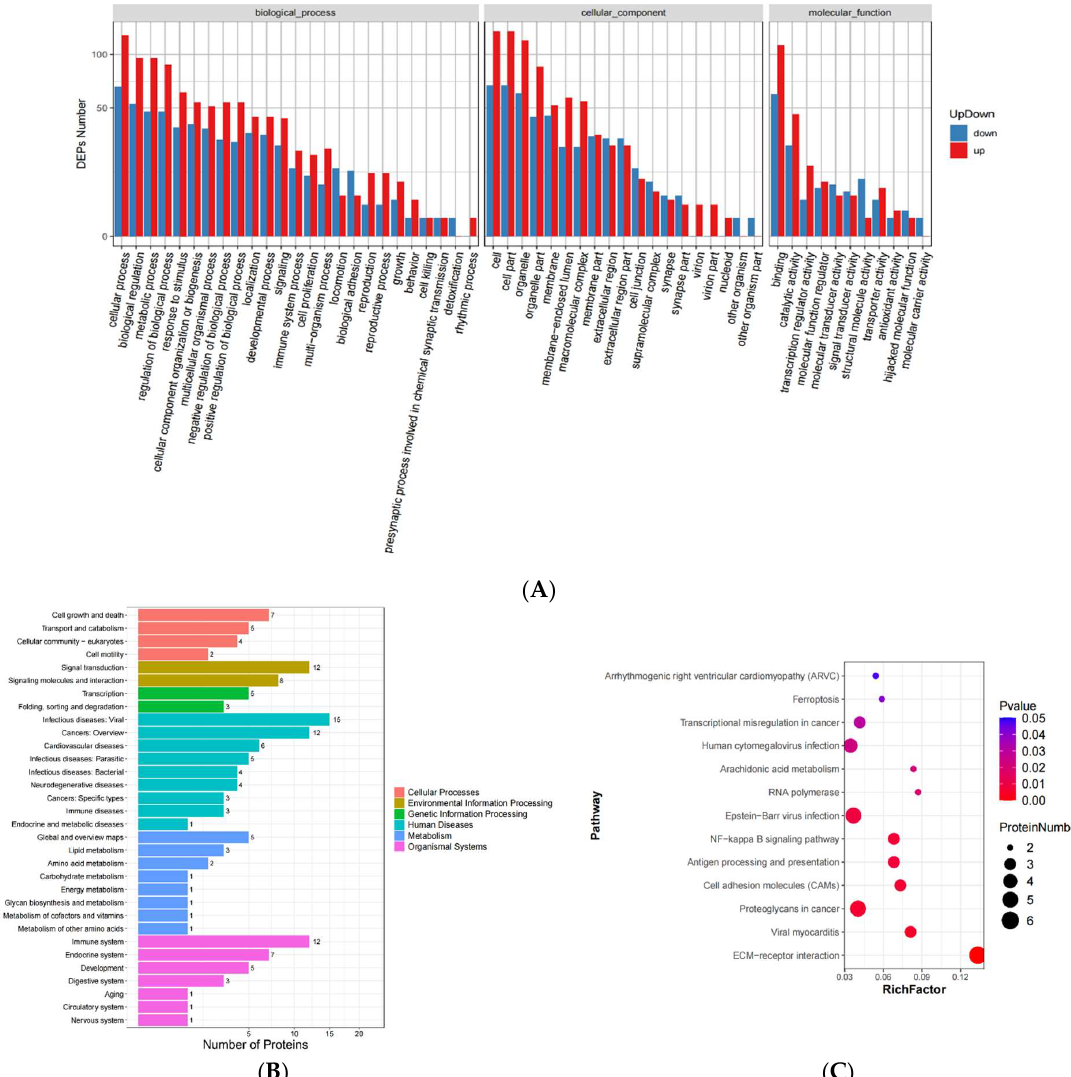
Figure 2 . Screening of proteins related to the immune response of MDCK cells after IAV H1N1 infection. ( A ) Preliminary GO results for all 266 differentially expressed proteins, which are classified according to biological process, cellular component, and molecular function. ( B ) The GO results of 42 differentially expressed proteins after screening for proteins related to cellular innate immunity and viral response, which are classified according to biological process, cellular component, and molecular function. ( C ) KEGG analysis of 42 differentially expressed proteins after screening for proteins related to cellular innate immunity and viral response, and the different signaling pathways involved in the regulation of these proteins, were classified.